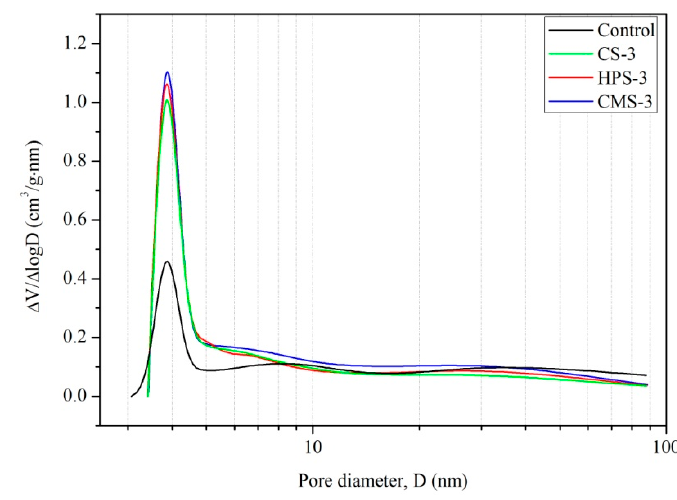
Figure 12. Pore size distribution (<130 nm) of 200 °C-heated specimens immersed in water for 24 h.